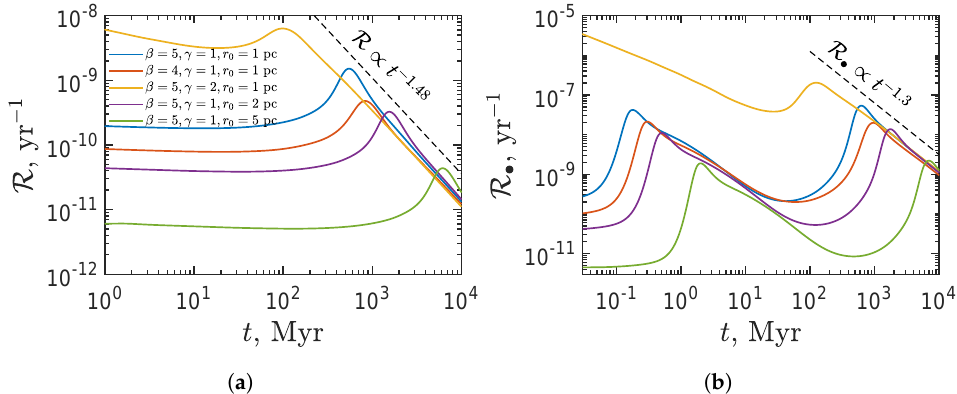
Figure 3. The time dependence of the merger rate of PBHs for the different parameters of the density profile is shown. ( a ) The merger rate of PBHs between each other. ( b ) The capture rate of PBHs by the central massive BH. The legend is the same as in the left